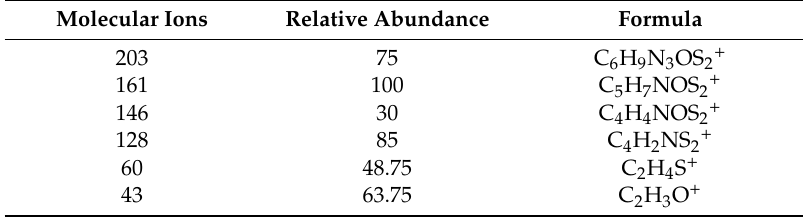
Table 5. The selected molecular ions with their formula and their relative abundance of Compound 1